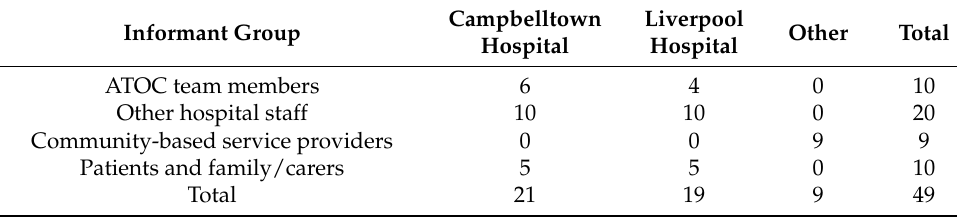
Table 1. Participants by informant group and